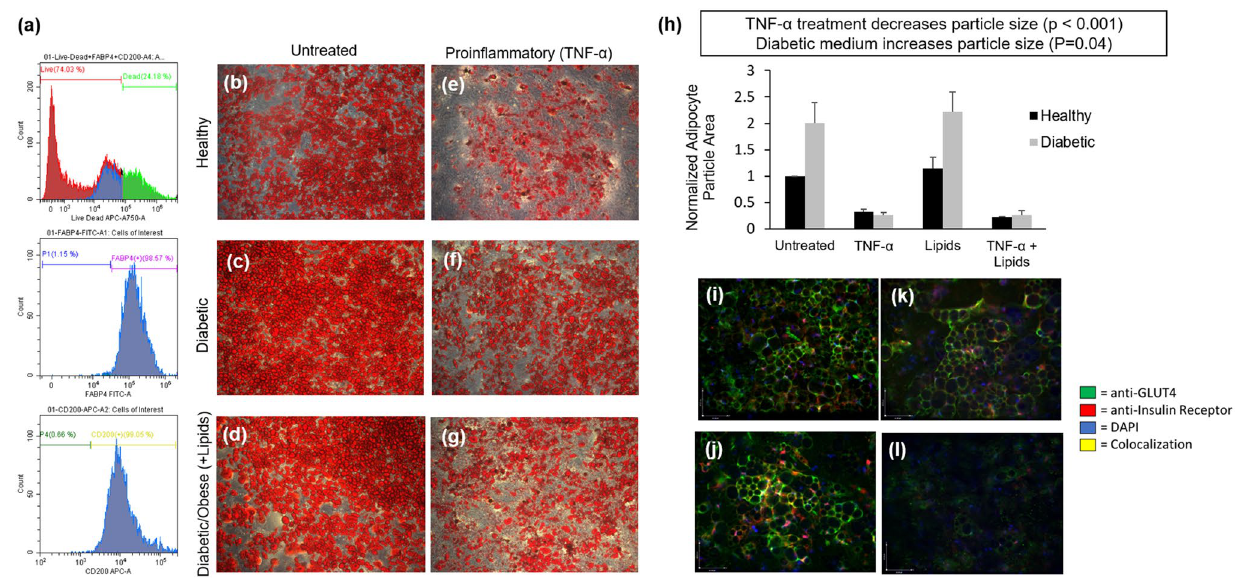
Figure 2. Characterization of adipocytes in monoculture. ( a ) Cytometer live/dead, FABP4, and CD200 staining of adipocytes after 14d differentiation. Oil Red O staining showing lipid storage in adipocytes after differentiation and 14-day treatment in ( b ) Healthy BMM ( c ) Diabetic BMM ( d ) Obese BMM ( e ) Proinflammatory BMM ( f ) Diabetic + proinflammatory BMM ( g ) Obese + proinflammatory BMM). ( h ) Quantification of lipid droplet size using ImageJ particle analysis. ICC quantification of insulin resistance biomarkers after 14d in ( i ) Healthy BMM ( j ) Diabetic BMM ( k ) Diabetic + Obese BMM ( l ) Diabetic, obese, and proinflammatory BMM. Statistical analysis performed as multi-way ANOVA followed by Dunnett’s test (α = 0.05) using the coverslip-wide average of two independent coverslips per